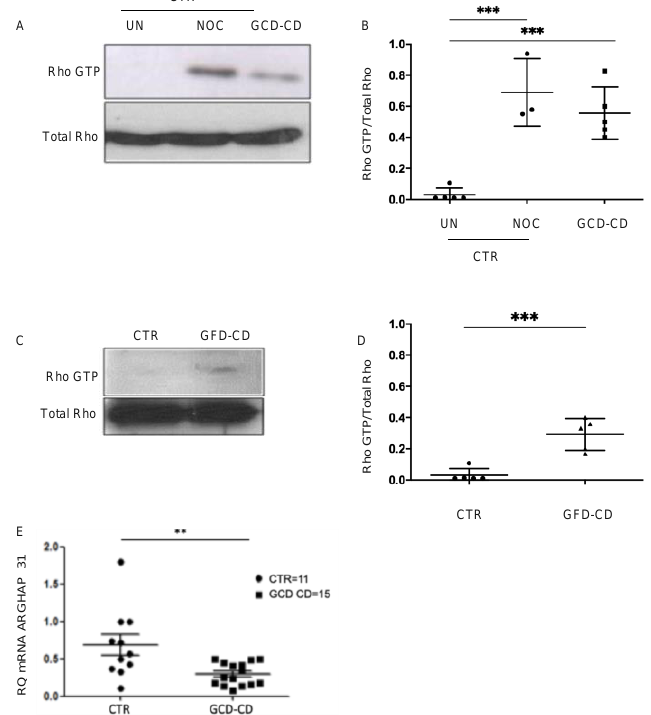
Figure 1. Rho-GTP and Rho GTPase-activating protein (ARHGAP) levels in dendritic cells (DCs) from celiac disease (CD) patients and controls. Ras homolog family member A (RhoA)-GTP levels are higher in DCs from CD patients than controls (CTR) after seeding on fibronectin for 1 h. 10 6 DCs were plated for each subject and each condition. ( A ). Representative Western blot (WB) of RhoA activity (RhoA)-GTP levels in dendritic cells (DCs) from one control (CTR) and one celiac patient on a gluten-containing diet (GCD-CD). DCs from CTR were analyzed before (untreated, UN) and after treatment with nocodazole (NOC). ( B ). Densitometric analysis of WB performed as in A from five CTRs and five GCD-CD. NOC was used as a positive control on DCs from three CTRs. Compared with UN DCs from CTRs, NOC promoted RhoA activation, reaching similar levels to those observed in GCD-CD. Horizontal lines represent the mean; bars, the standard deviation. Ordinary one-way ANOVA with Tukey’s multiple comparison correction was performed; *** p < 0.001. ( C ). Representative WB